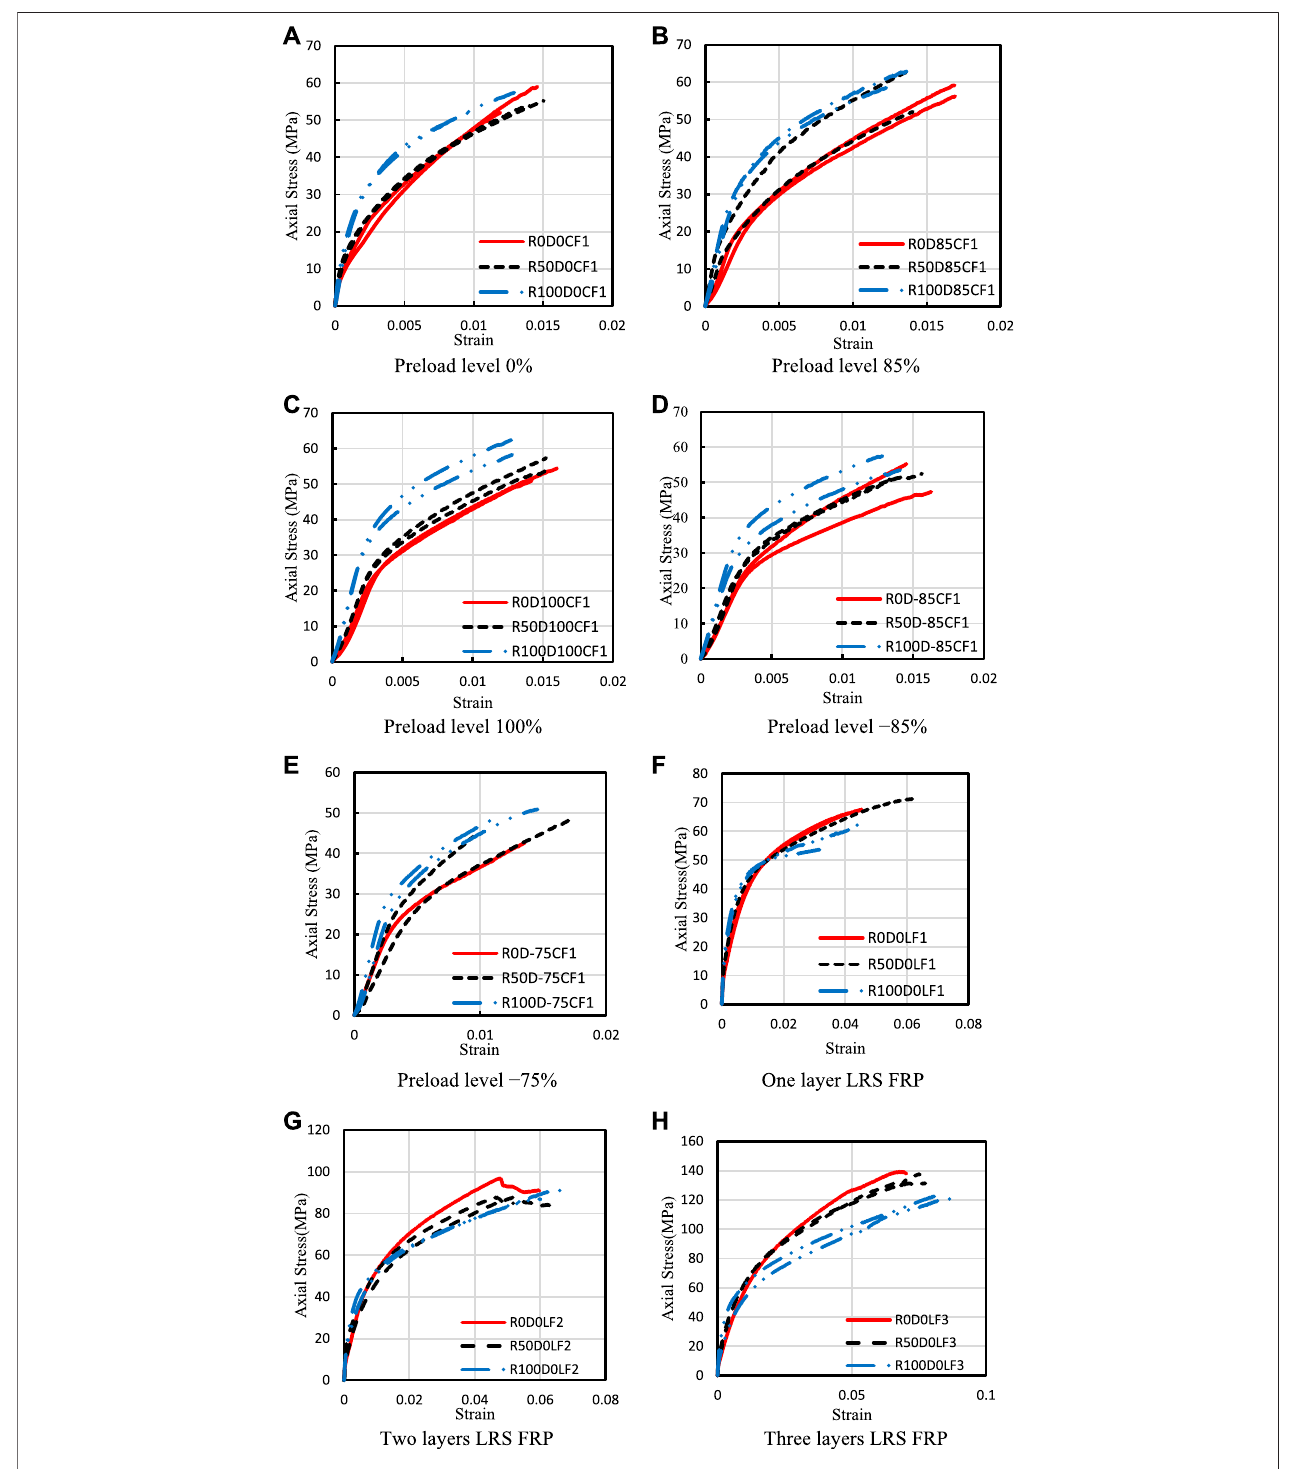
Figure 13 | The stress-strain curve with different RAs replacement